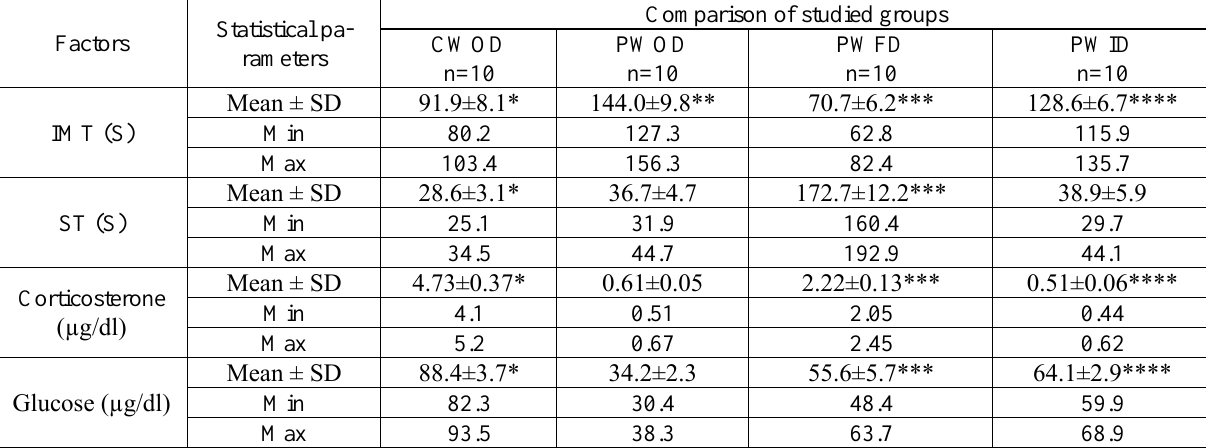
Comparison of studied groups